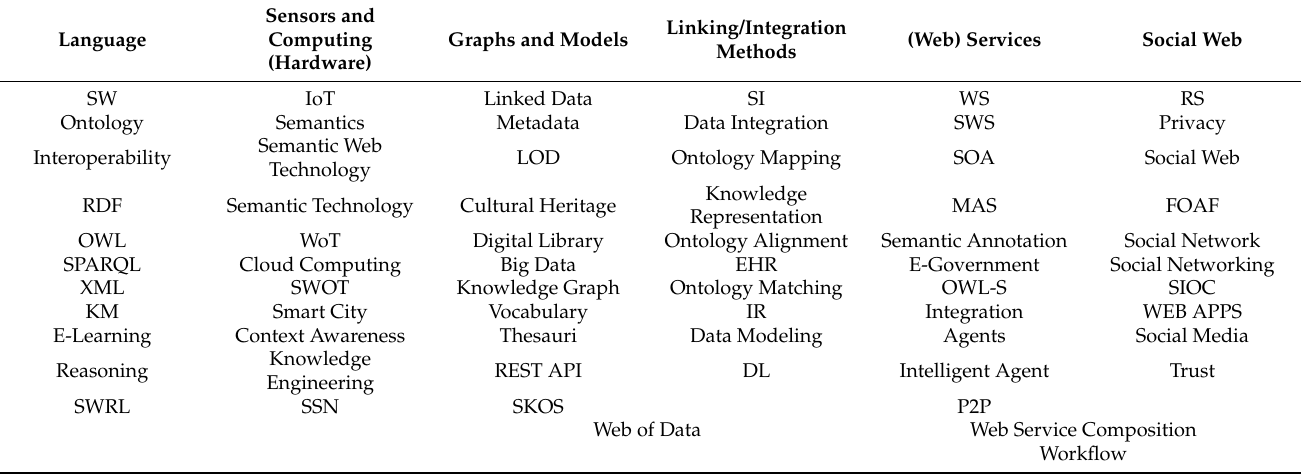
Table 8. The top 10 most frequent keywords in each